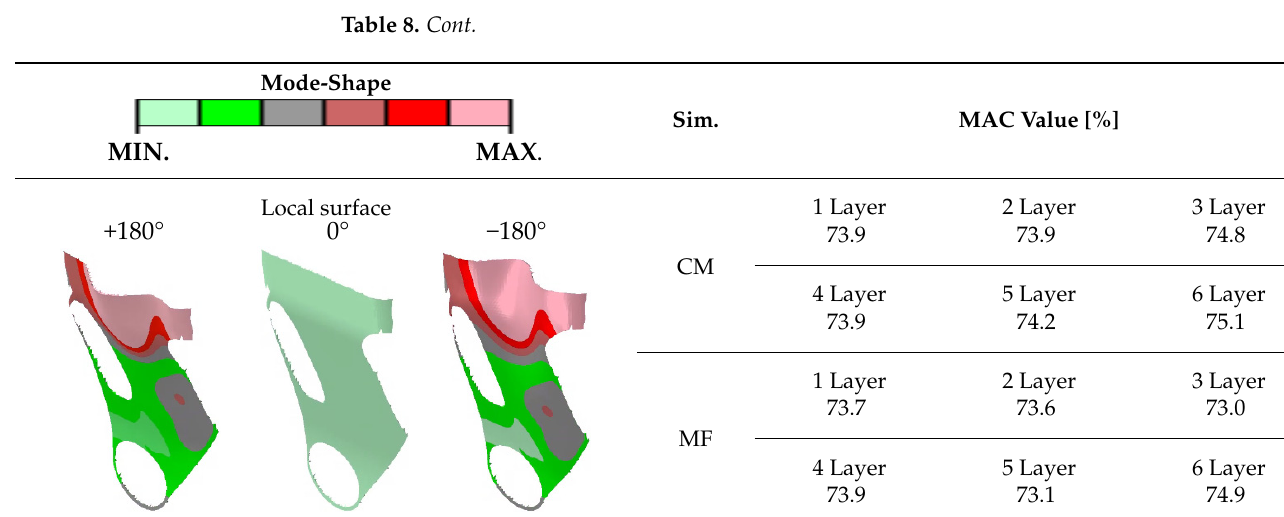
Table 8. Mode shapes of the structural dynamics simulation and MAC values in comparison to the Table 8. Cont. experiment of the PA66GF50 engine bracket.